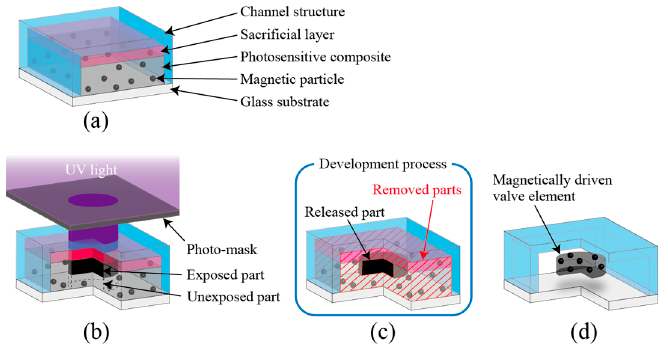
Figure 1. Principle diagram of proposed fabrication process: ( a ) making process of laminating layer in closed channel; ( b ) UV exposure process; ( c ) development process; ( d ) after development process.